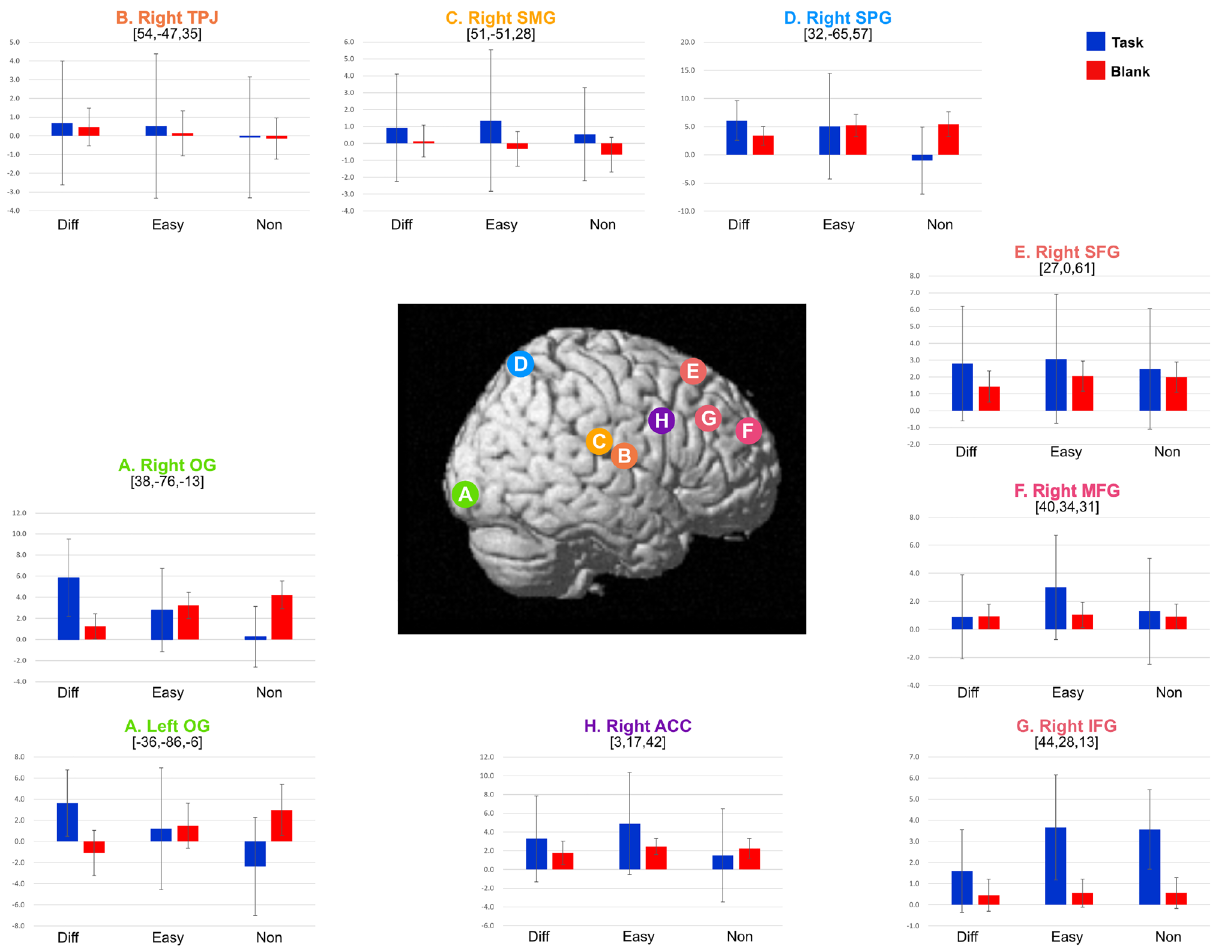
Figure 3. Beta values of all ROIs in all phases. Illustration of brain in middle indicates position of each ROI. ( A ) Right/left OG; occipital gyrus, ( B ) right TPJ; temporoparietal junction, ( C ) right SMG; supramarginal gyrus, ( D ) right SPG; superior parietal gyrus, ( E ) right SFG; superior frontal gyrus, ( F ) right MFG; middle frontal gyrus, ( G ) right IFG; inferior frontal gyrus, and ( H ) right ACC; anterior cingulate gyrus. The bar graphs indicate the average, and the error bars are standard deviations.